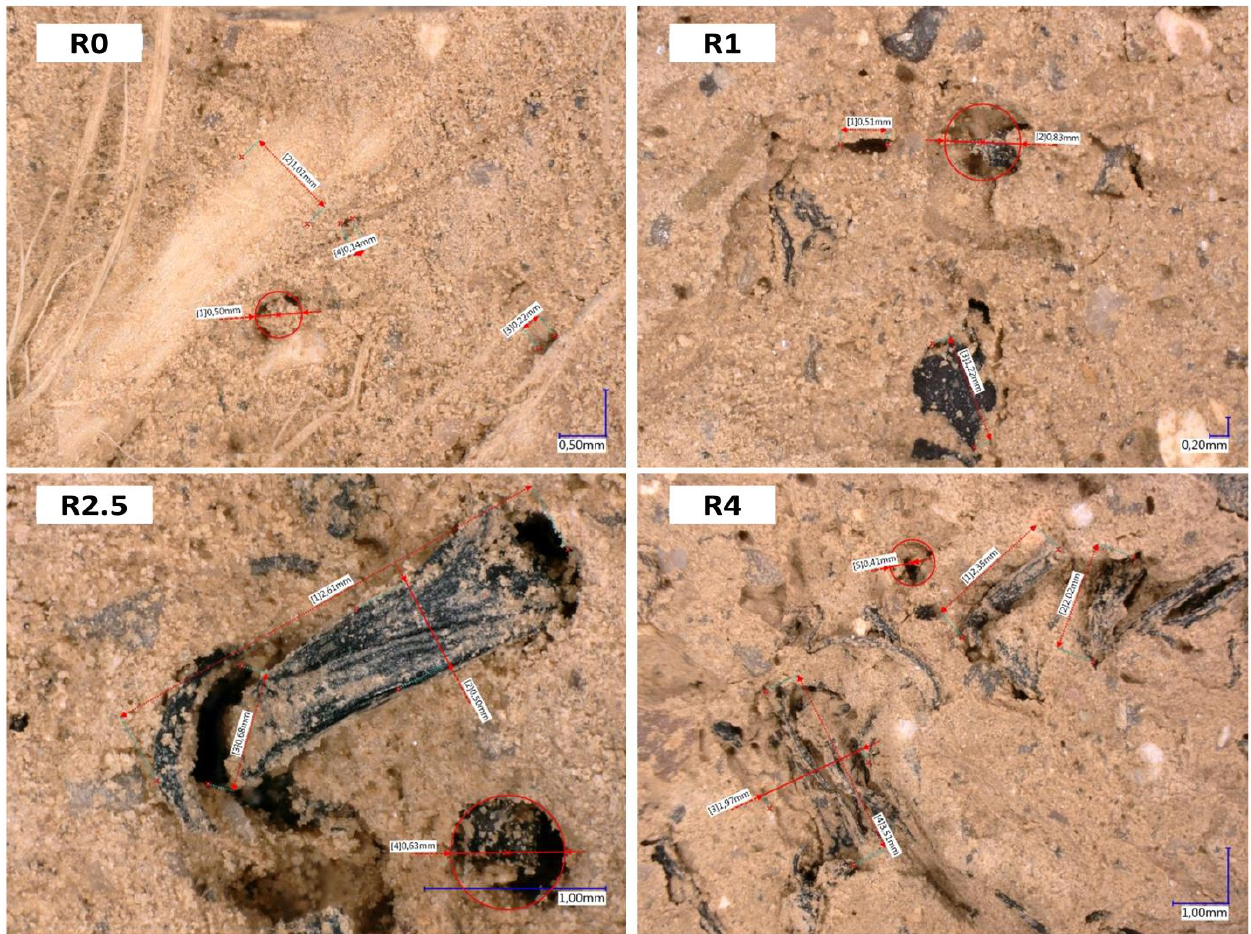
Figure 5. Cob’s density and open porosity variation versus Sargassum muticum content.